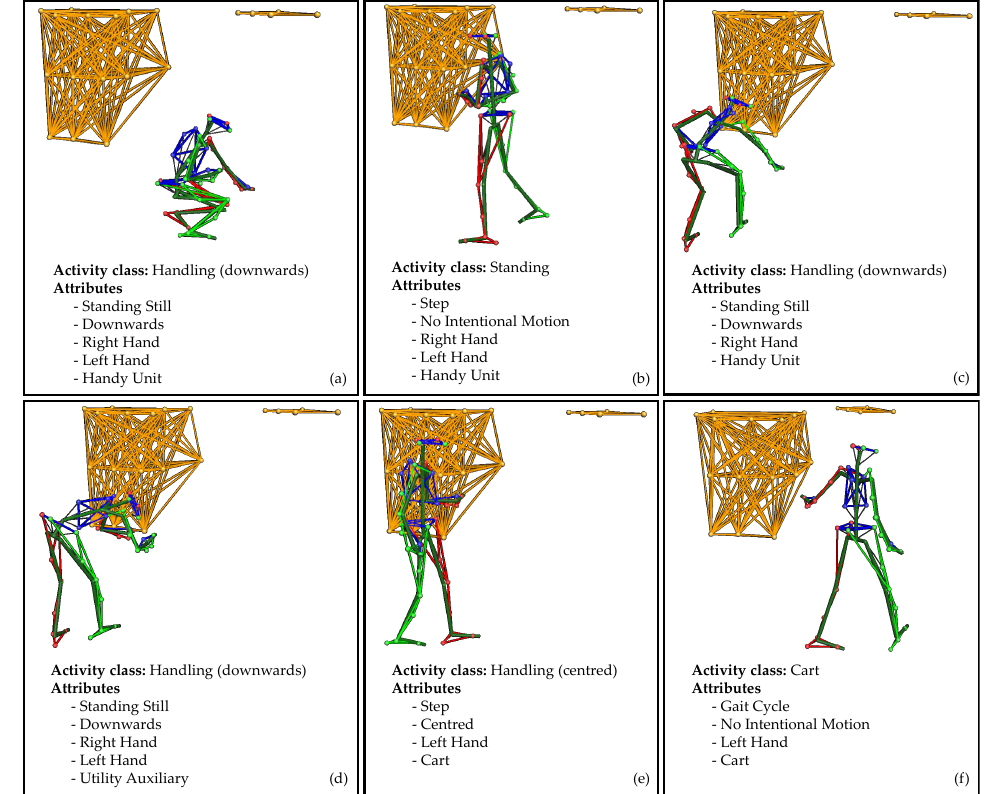
Figure 5. Example of an annotation sequence of six